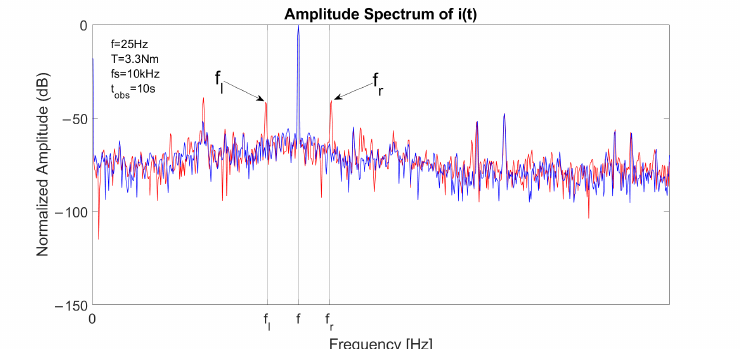
Figure 10. Spectrum of a stator current signal from experimental acquisition in healthy (blue) and faulty (red) conditions, with fundamental component located at f , left sideband component located at f l = ( 1 − 2 s ) · f and right sideband component located at f r = ( 1 + 2 s ) · f .